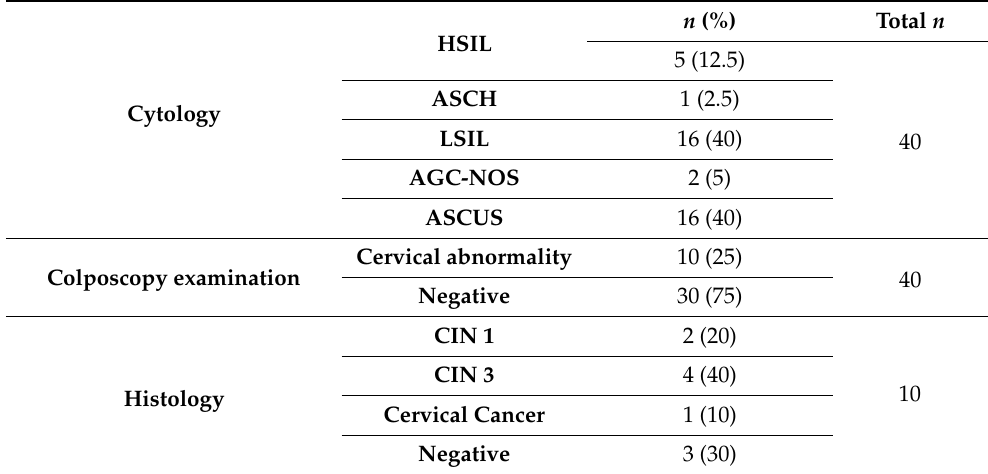
Table 1. Clinical results of the cohort of enrolled